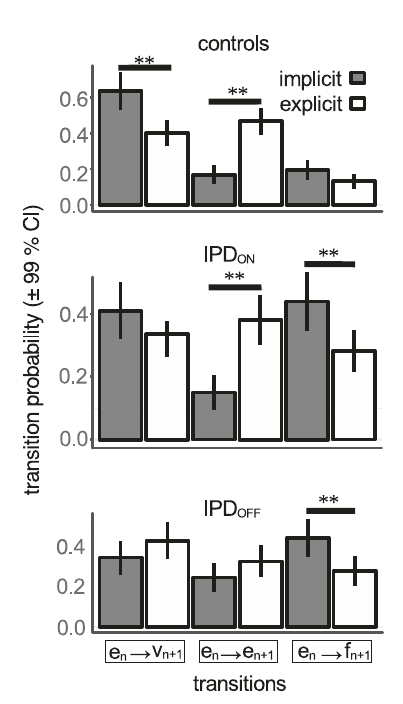
Fig. 7 3-state Markov process. a Schematic representation of the 3-state Markov process hypothetically underlying sequences of trials in the implicit and explicit conditions for both groups of subjects. Each node represents a given state ( ‘ e ’ : early response; ‘ v ’ : visually- guided saccade; ‘ f ’ : failed trial). Arrows represent transitions between states in trial ‘ n ’ and ‘ n + 1 ’ . Note that a transition can lead to the same state during trial ‘ n ’ and trial ‘ n + 1 ’ (looping back arrows). All states were reachable regardless of the starting state forming a communicating class and the chain was irreducible without absorbing state (i.e., impossibility to escape from a state). These states were mutually exclusive (e.g., a trial cannot be e & v) and exhaustive given that all trials belonged to one or the other category. b Transition matrices for the different groups and conditions. Dashed rectangles indicate signi fi cant differences in the e n row in the explicit condition.